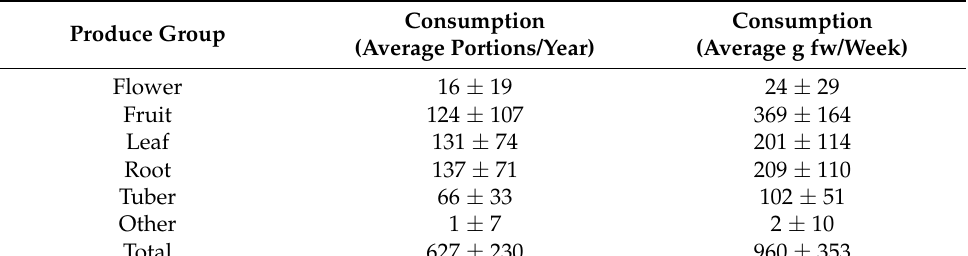
Table 1. Produce consumption by produce group. Consumption of produce in g/week was calcu- lated using a conversion factor of one portion ≈80 g fw (NHS, 2015). Values are averages (mean) ± standard deviation.